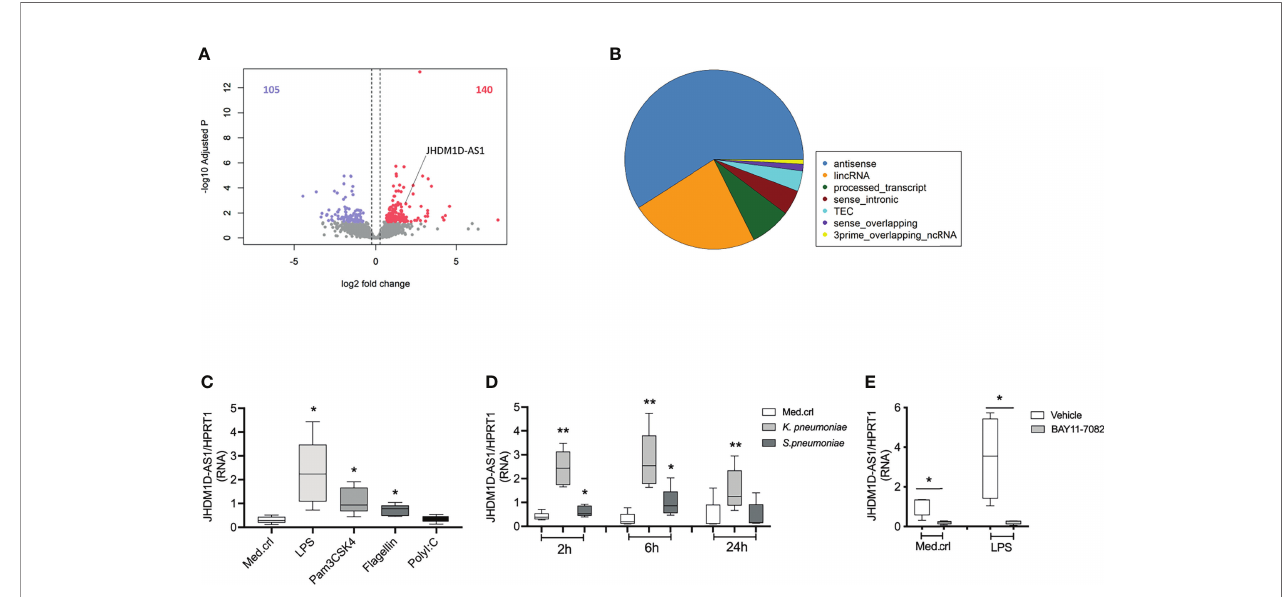
FIGURE 1 | JHDM1D-AS1 expression patterns in primary human monocytes during sepsis and after stimulation. (A) Volcano plot showing signi fi cantly altered long non-coding RNA (lncRNA) identi fi ed by RNA sequencing analysis of CD14 + monocytes puri fi ed from critically ill patients with sepsis due to community-acquired pneumonia (CAP), relative to healthy donors (n = 6). Red denotes elevated expression (adjusted p < 0.05, fold change ≥ 1.5); blue denotes reduced expression (adjusted p < 0.05, fold change ≤ − 1.5). (B) Pie chart illustrating the distribution of lncRNA biotypes among signi fi cantly altered lncRNAs. (C, D) RT-qPCR analysis of JHDM1D-AS1 expression in primary monocytes exposed to different Toll-like receptor (TLR) ligands for 2 h or challenged with heat-killed bacteria for 2, 6, and 24 h (n = 5). (E) Primary monocytes were pretreated ( − 30 min) with BAY11-7082 or DMSO (vehicle) followed by LPS stimulation for 2 h (n = 4). The expression levels of JHDM1D-AS1 were quanti fi ed with RT-qPCR. The boxes extend from the 25th to 75th percentiles, the whiskers range from minimum to maximum, and the horizontal line indicates the median. Paired student ’ s t-tests were performed for the indicated comparisons. *p < 0.05; **p <